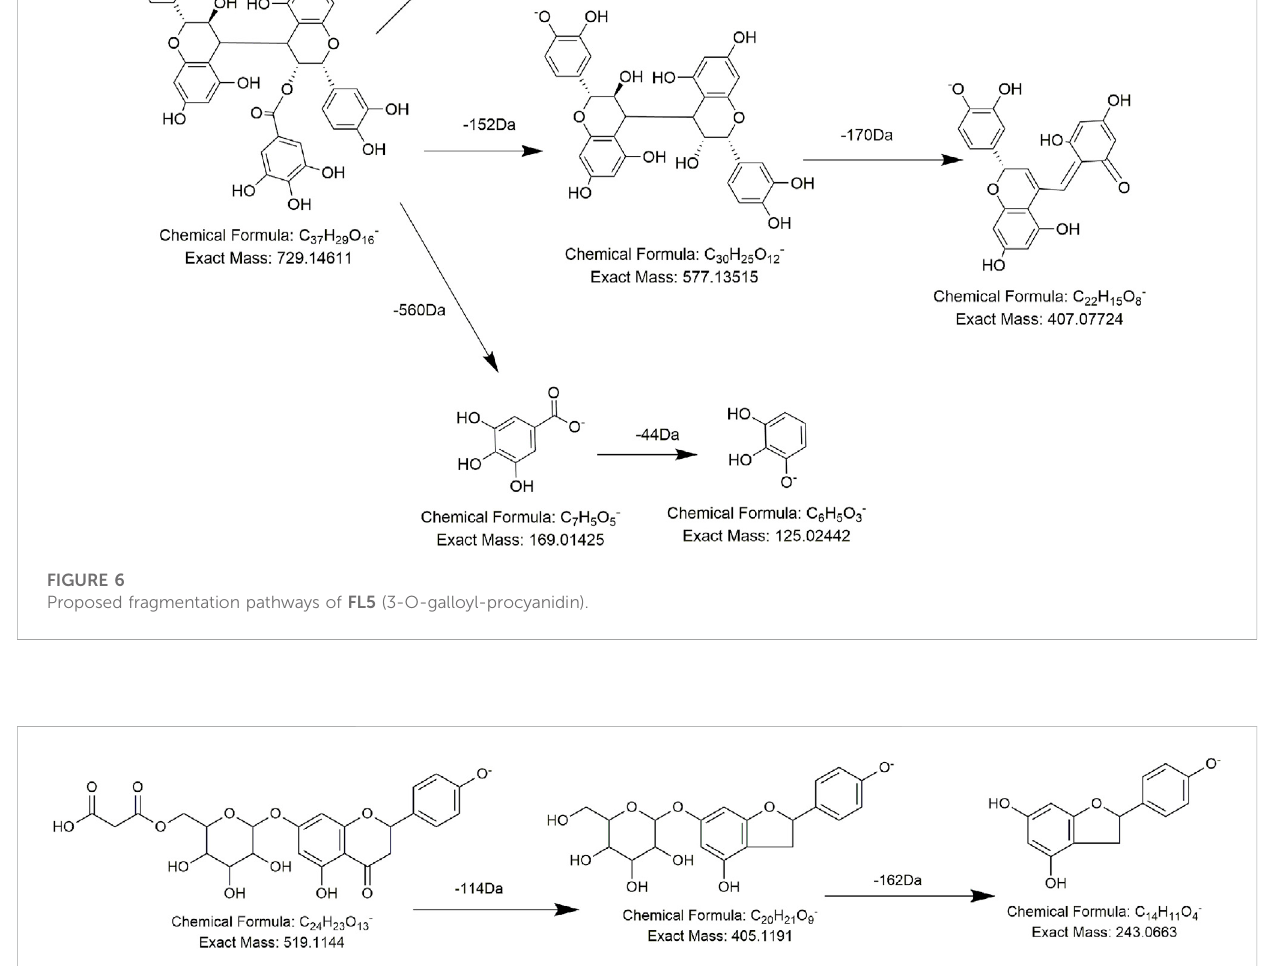
FIGURE 7 Proposed fragmentation pathways of compound FL4 (new